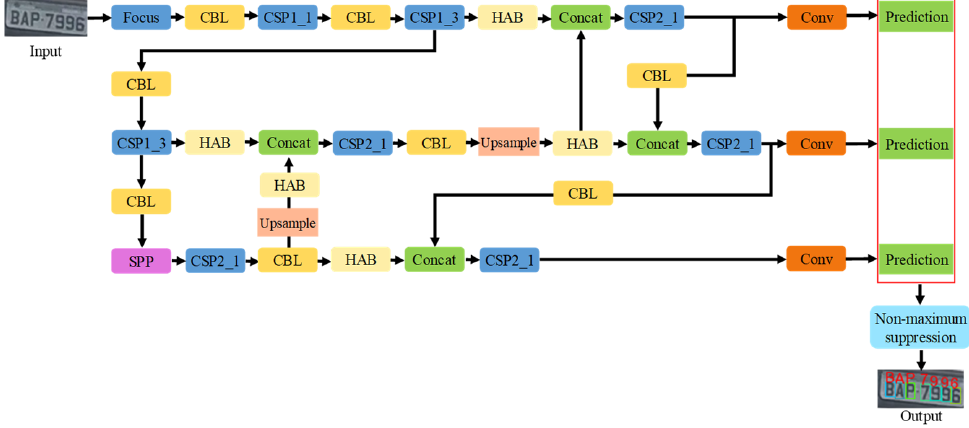
Figure 6. Flowchart of LP recognition module based on high-frequency augmentation. Algorithm 2. The pseudocode of the LP recognition module based on high-frequency augmentation.